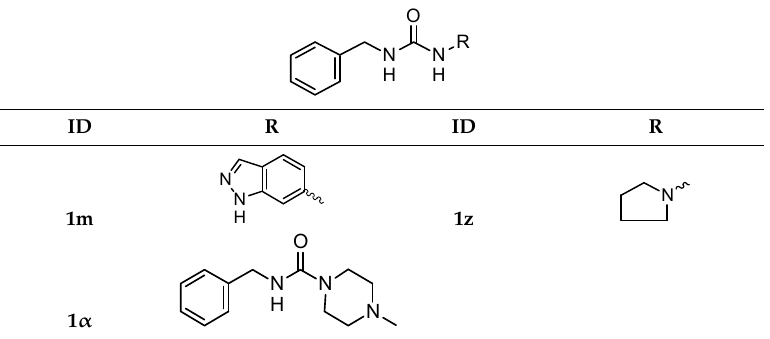
Figure 2. Structural modifications performed on Hit 2 . Table 1. Cont. Table 1. Urea derivatives 1a – α .